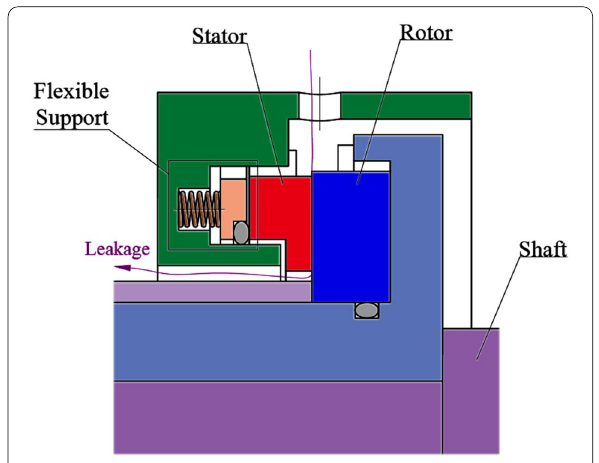
Figure 1 Typical structure of a spiral groove gas face seal